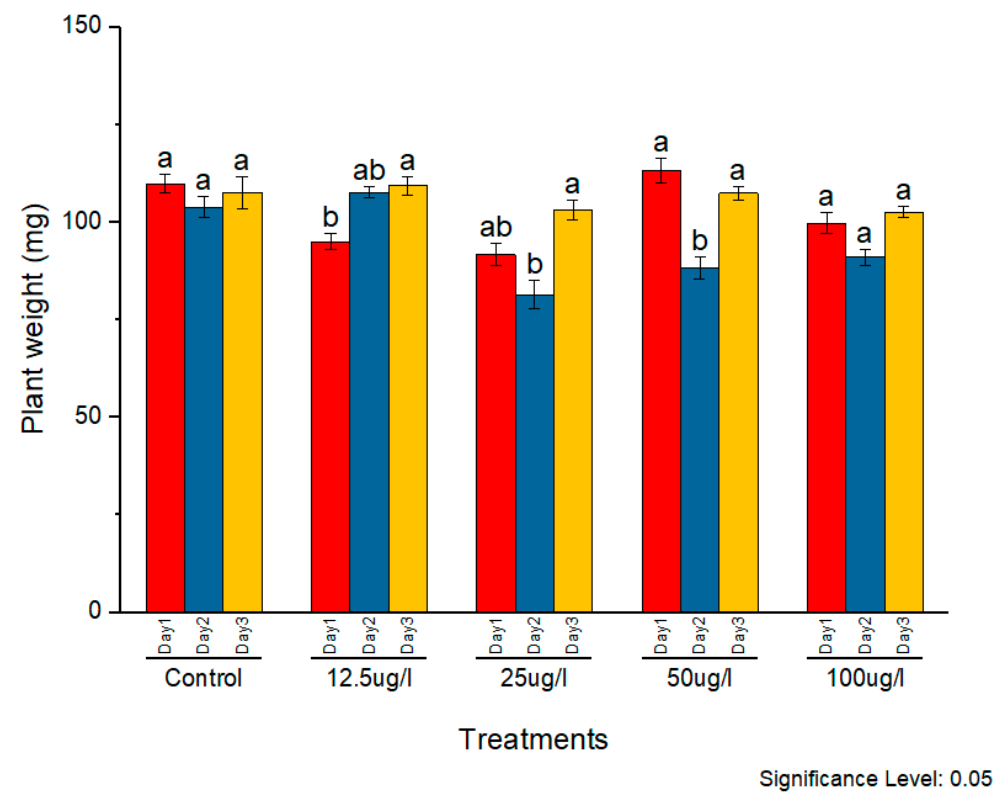
Figure 11. Phytotoxic effects of AgNPs on plant weight, a and b indicates two significance sub groups based on Latin Square Design (LSD) value.